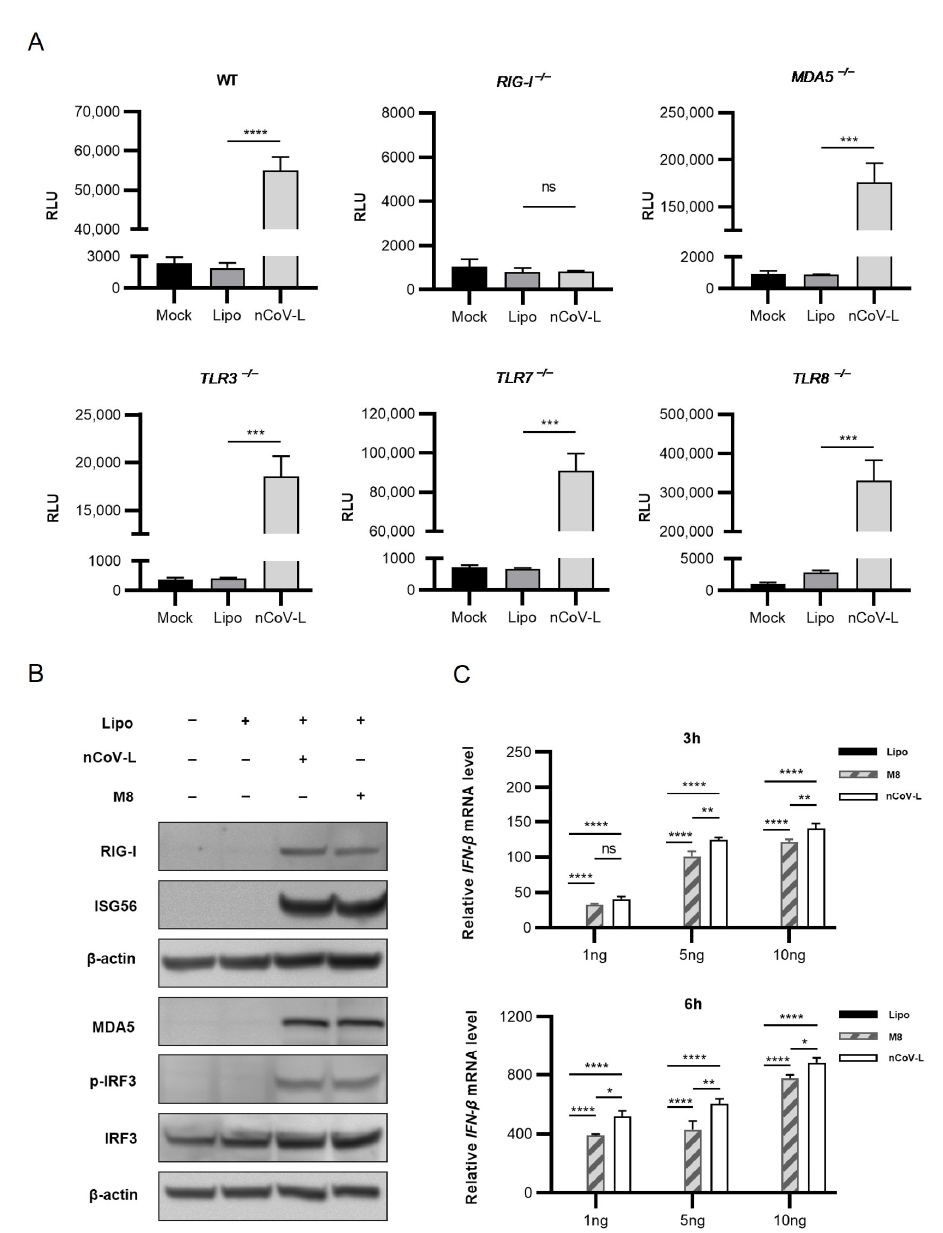
Figure 1. nCoV-L induces an interferon response by activating the RIG-I receptor. ( A ) 1 × 10 4 wild-type (WT), RIG-I − / − , MDA5 − / − , TLR3 − / − , TLR7 − / − , TLR8 − / − , and HEK293 cells expressing ISG54 -luciferase reporter gene were cultivated in 96-well plate for 12 h, and then transfected with 50 ng nCoV-L using Lipofectamine 3000 (short for Lipo) or treated with equal dosage of Lipo as the negative control. Relative luciferase activity was tested after 24 h. N = 3, RLU indicates relative light unit, bar indicates SD. ( B ) 2 × 10 6 A549 cells were transfected with 1 ng/mL nCoV-L or M8 using Lipo. Cell lysis was prepared and subjected to Western blot analysis 24 h after transfection. ( C ) 2 × 10 6 A549 cells were transfected with 1 ng/mL,5 ng/mL or 10 ng/mL nCoV-L or M8 using Lipo. Cells were harvested 3 h or 6 h after transfection and total RNA was extracted. Relative IFN- β gene expression levels were determined by RT-qPCR. N = 3, bar indicates SD. ns, p > 0.05, *, p < 0.05, **, p < 0.01, ***, p < 0.005, ****, p < 0.001.